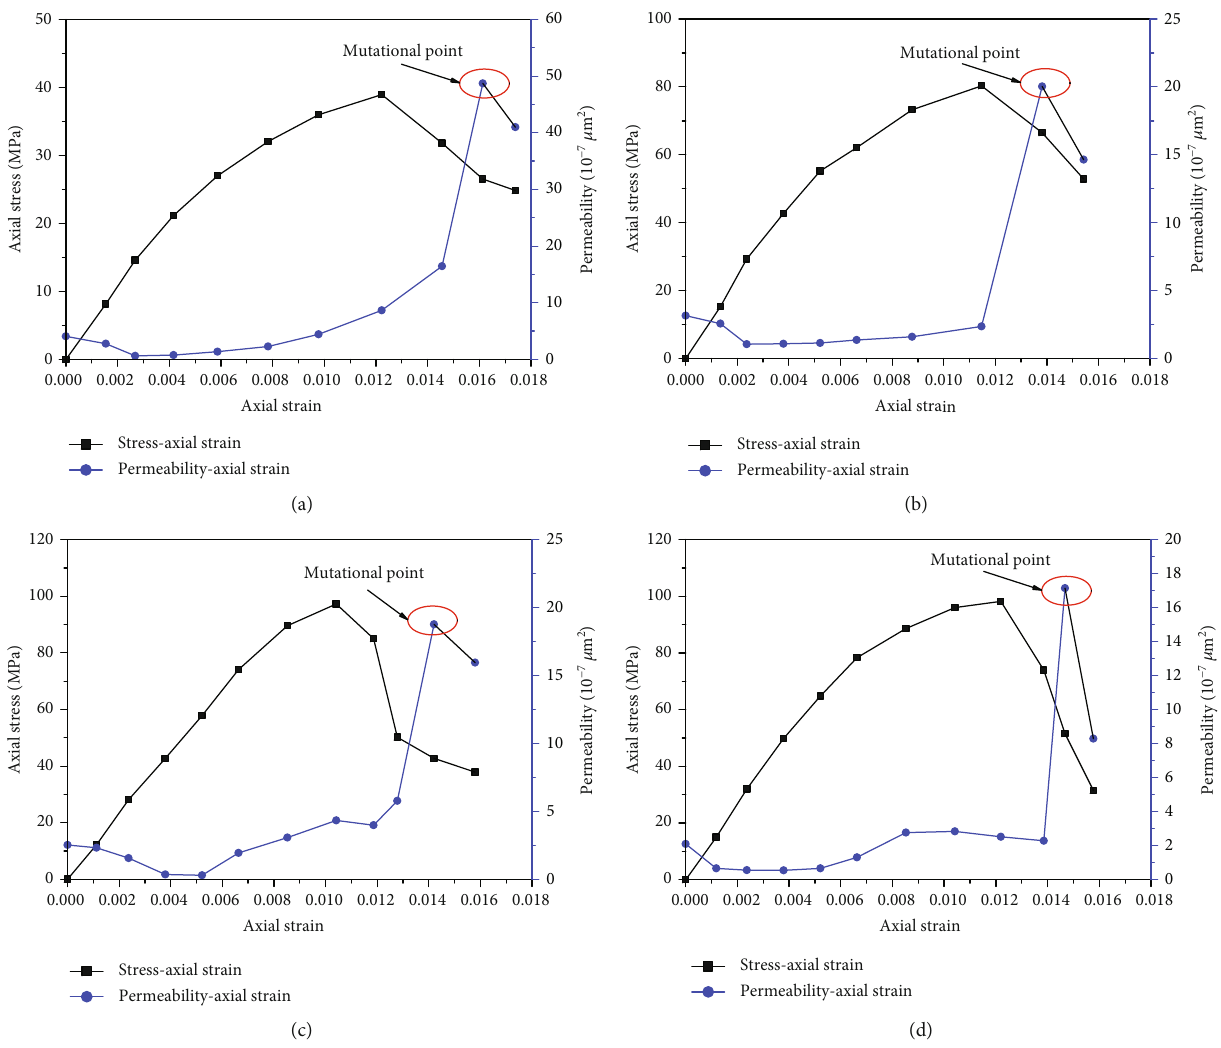
Figure 3: The relationships between stress, permeability, and axial strain under di ff erent con fi ning pressures. (a) 4 MPa; (b) 6 MPa; (c) 8 MPa; (d) 10